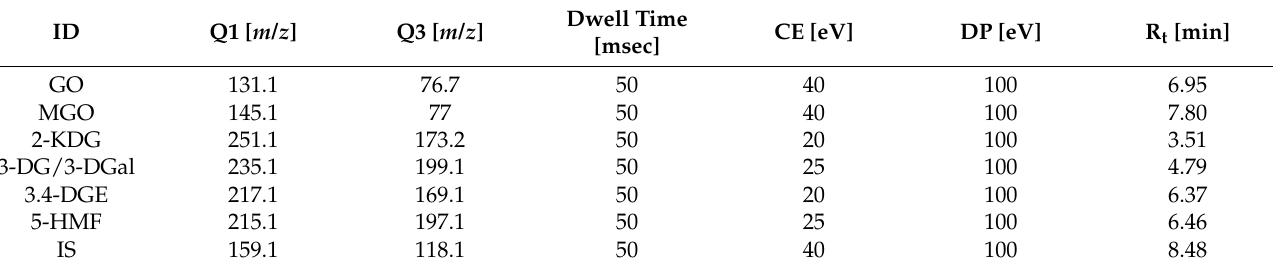
Table 14. Parameters of the LC-MS/MS